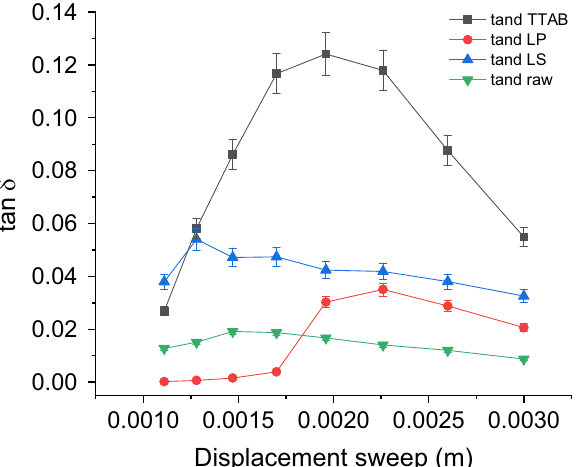
Figure 7. Elastic E’ and viscous E’’ moduli as a function of an increase in the deformation applied (displacement